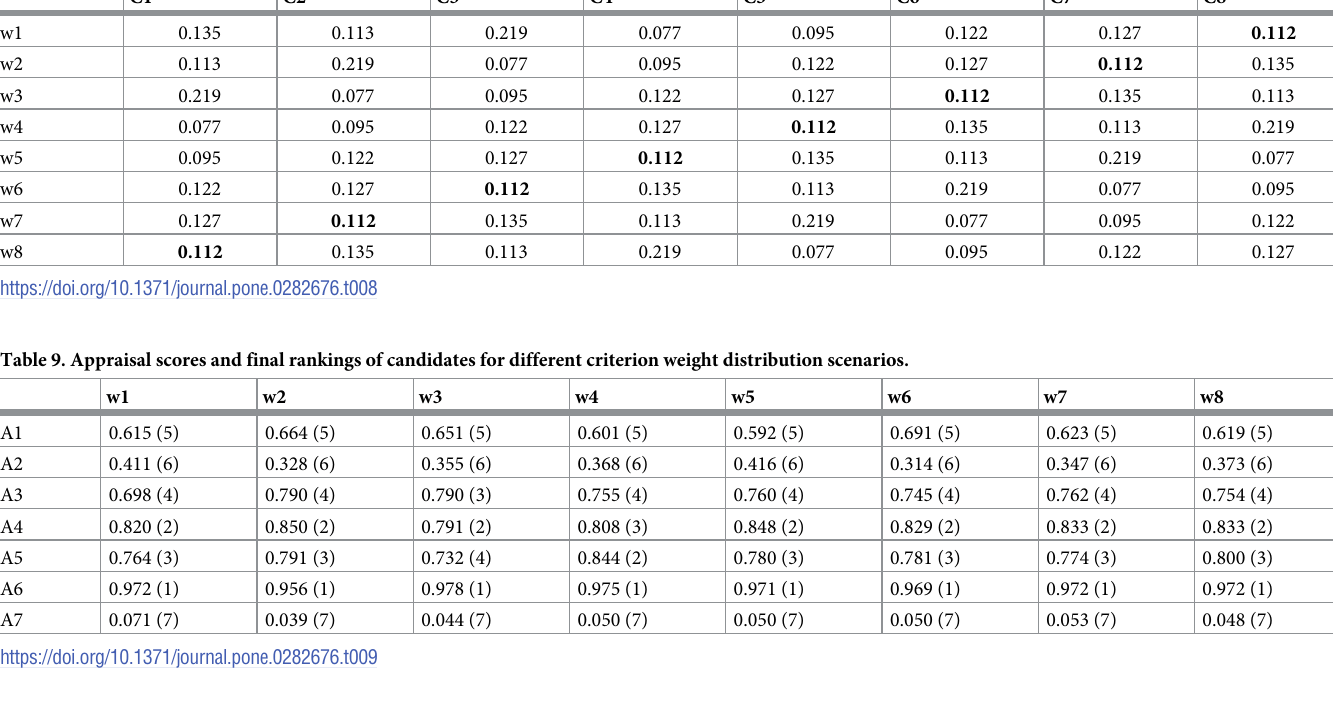
Table 10. Decision-expert (DE) weight distributions (DE1; DE2;